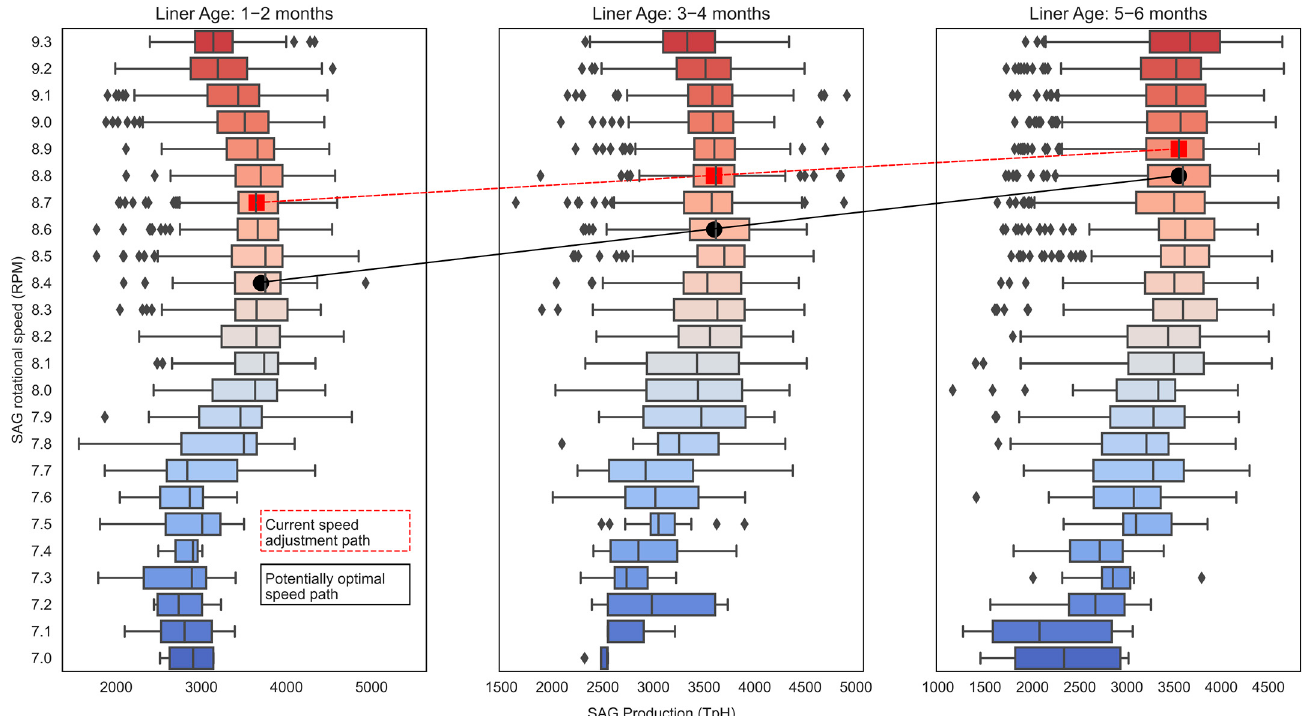
Figure 10. SAG production (TpH) versus SAG rotational speed (RPM) and liner age. After identifying the optimal linear level of the mill’s rotational speed and age, the optimal levels were used to determine the optimal configuration points for solid percentage and pressure (see Figure 11). Then, for a scenario of 1–2-month-old liners, a hardness > 32.5, and an optimal rotational speed of 8.4 RPM, the SAG mill is usually operated at a percentage of solids of 70% and a pressure of 8000 kPa (see Figure 11a). However, to improve the performance of the SAG production in TpH, the ML model suggests adjusting the percentage of solids to approximately 73% (see Figure 11b) while keeping the